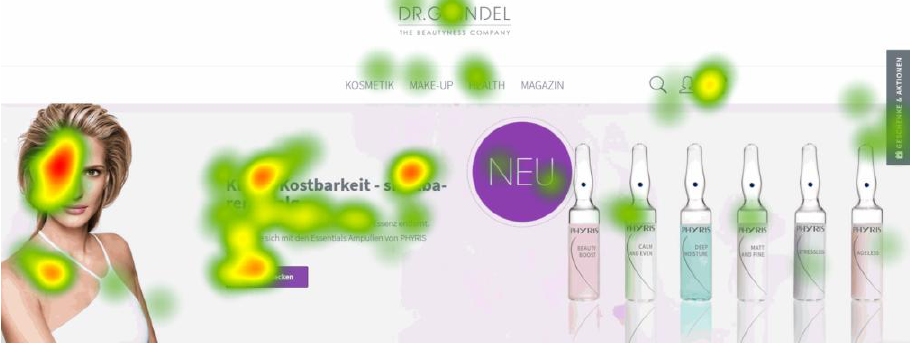
Figure 8. Heatmap for customers of the business [34]. Fixation focuses on subjective